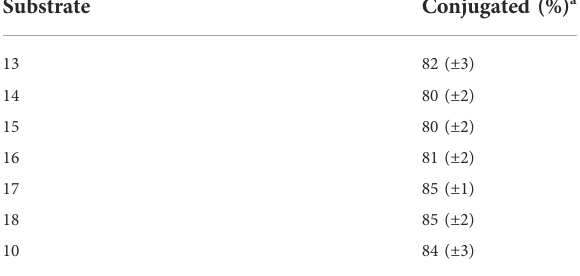
TABLE 1 Percentage of conjugated and unlabeled sortase sites on CTB – LPETGA after 2 h.